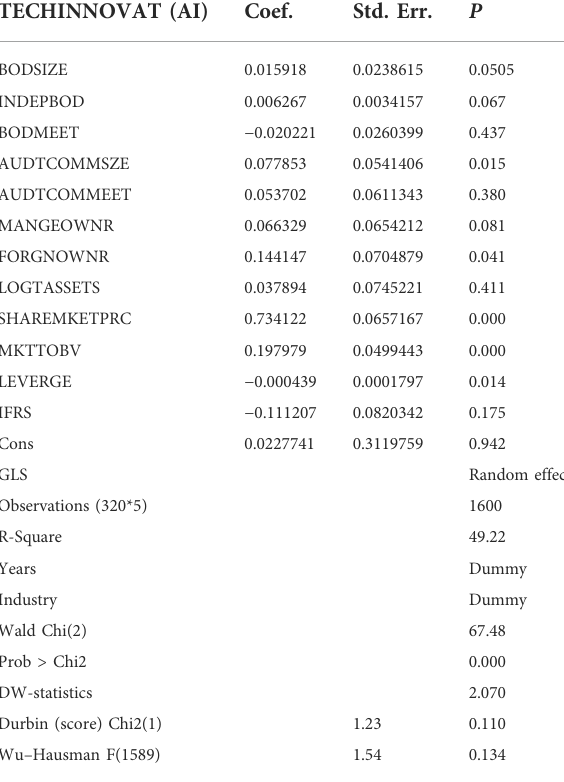
TABLE 4 Random effect (GLS) model 2 (B to C). TABLE 3 Random effect (GLS) model 1 (A to B).